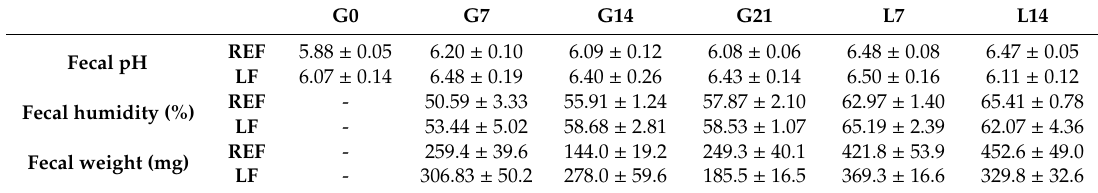
Table 4. Evolution of pH, humidity and weight of the dams’ feces throughout the study.